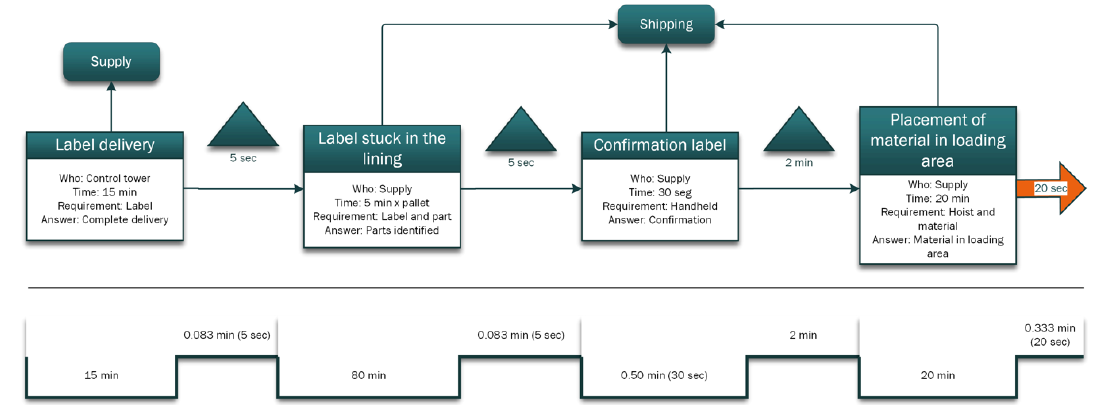
Figure 20. The second part of four of the future state map is displayed.